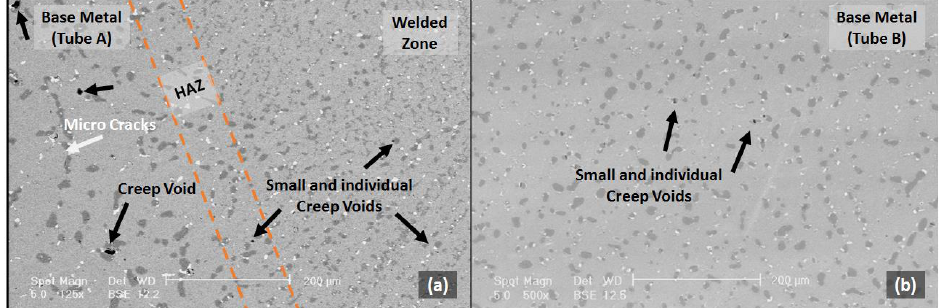
Figure 8. SEM images of ( a ) the interface between welded zone and base metal in tube A, ( b ) base metal in tube B.